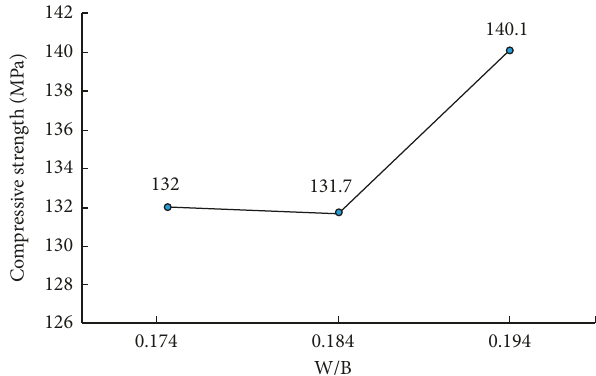
Figure 7: Influence of the W/B ratio on the compressive strength of UHPFRC when GGBFS replaced 20% of the cement.